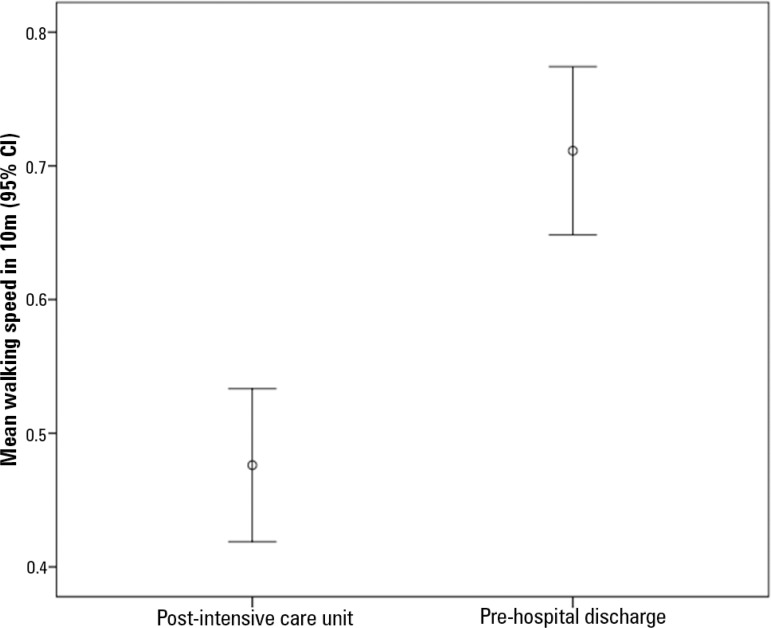
Speed on the 10-meter walk test. 95%CI- 95% confidence interval; ICU - intensive care unit. Mean ± standard deviation. Post-intensive care unit = 0.48 ± 0.18m/s; Pre-hospital discharge = 0.71 ± 0.20m/s; difference (95% confidence interval) = 0.24 (0.20 - 0.27); p < 0.001.